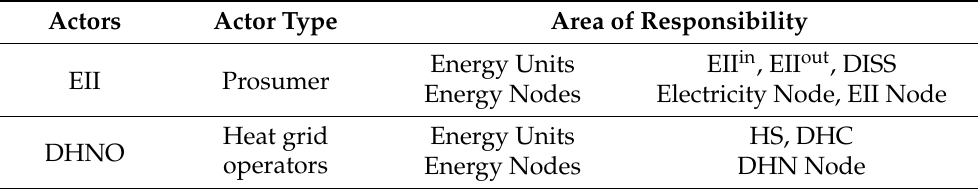
Table 4. List of actors present in the case study with their respective areas of responsibility.